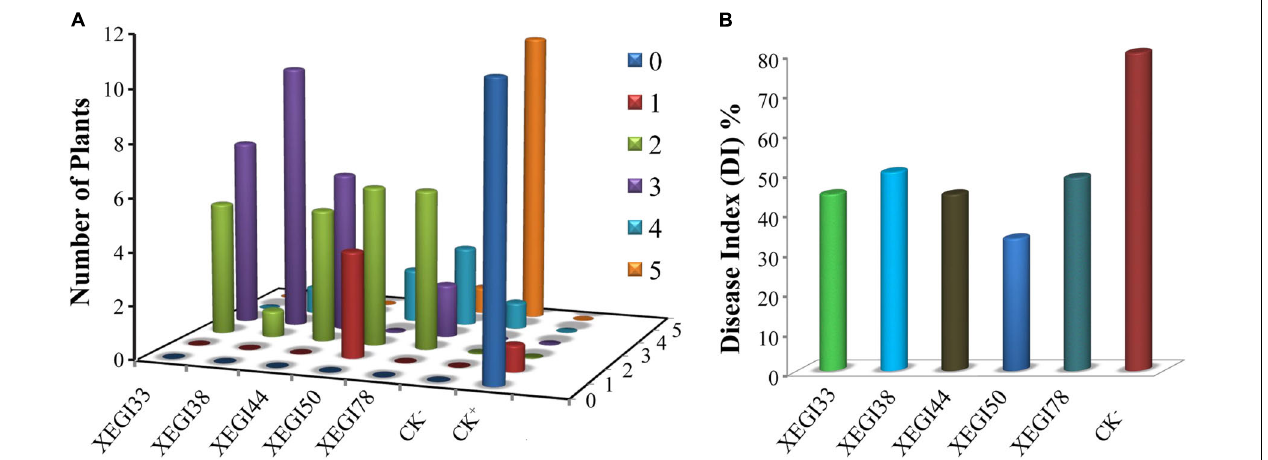
FIGURE 3 | Effect of antagonistic isolates on disease grades and disease index of Arabidopsis thaliana plants to V. dahliae over 5 weeks after inoculation of the pathogen. (A) Signs were rated along a scale that assigned disease grades ranging from ‘0’ to ‘5’ (0: no signs, 1: ≤ 25, 2: 25–35, 3: 35–45, 4: 45–55, 5: 55–80%); (B) disease index of Arabidopsis thaliana